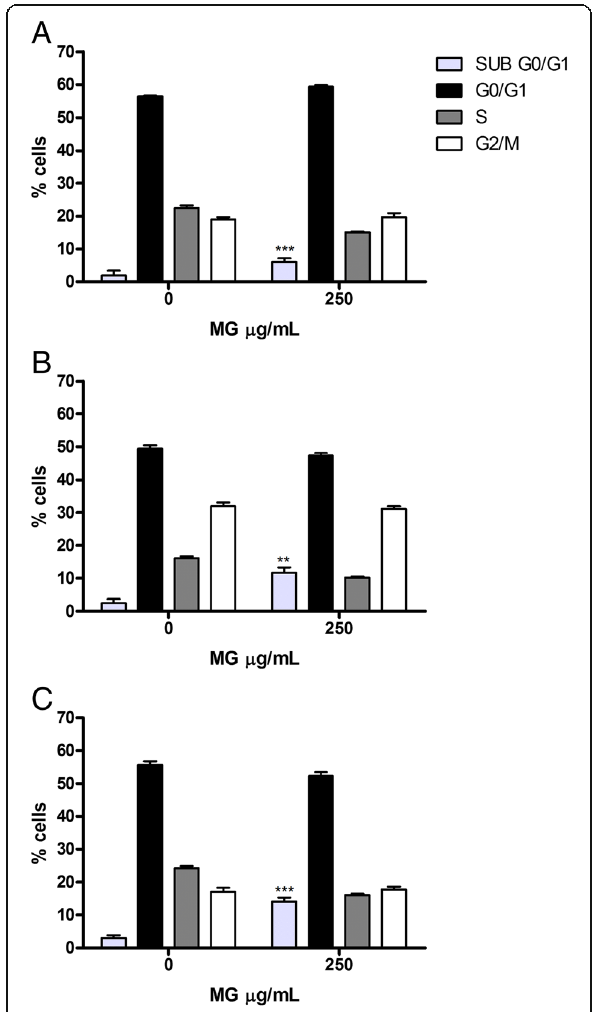
Fig. 5 Cell-cycle analysis of Jurkat cells treated with MG extract. Fraction of Jurkat cells in the different phases of the cell cycle after MG treatment for 24 h ( a ) 48 h ( b ) and 72 h ( c ) was evaluated as reported in Methods section. Each bar represents the mean ± SEM of five independent experiments. Data were analysed using repeated ANOVA followed by Bonferroni post-test and revealed no statistically significant differences